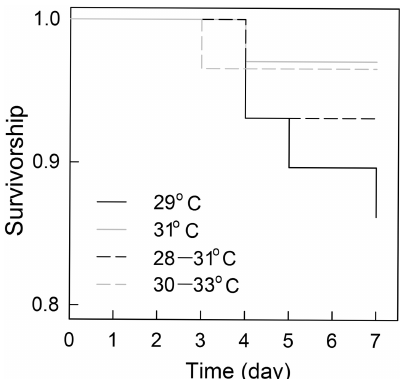
Figure 5. Survivorship of P. damicornis recruits estimated using Kaplan–Meier analysis in each treatment over the 7-day experi- ment. The numbers of recruits at the start of the experiment in each treatment are 30 for the treatments 29, 30–33 and 28–31 ◦ C and 35 for 31 ◦